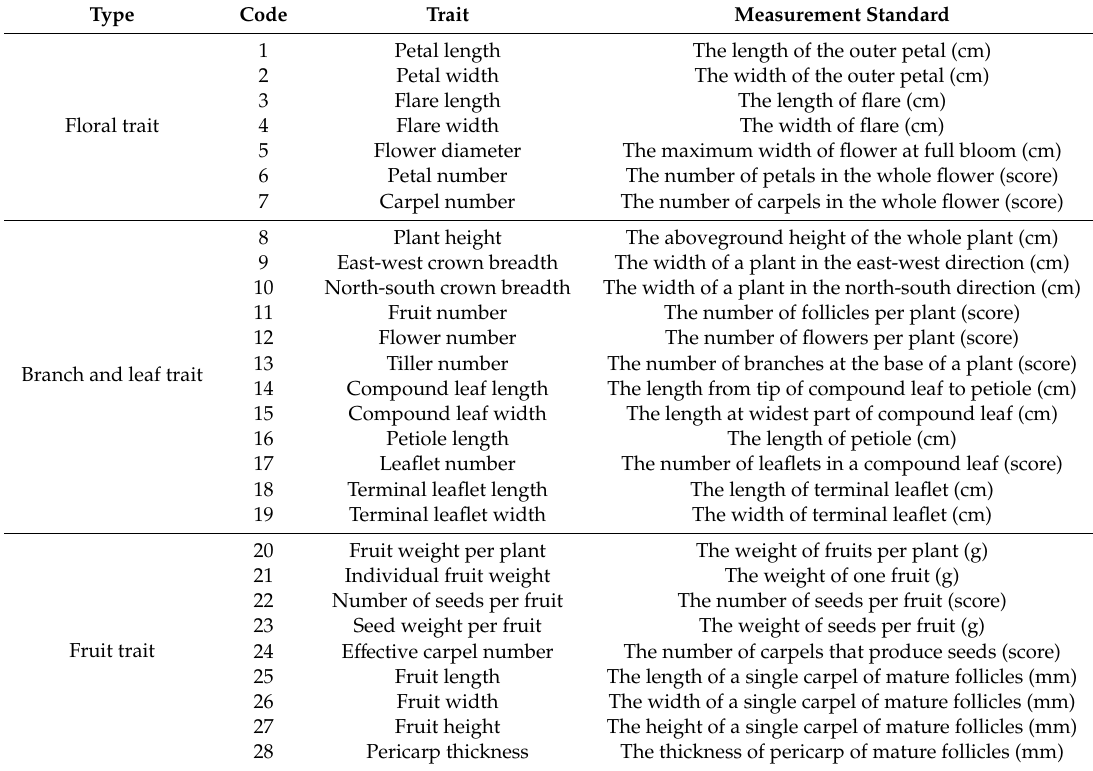
Table 1. Traits investigated of 180 accessions and the measurement